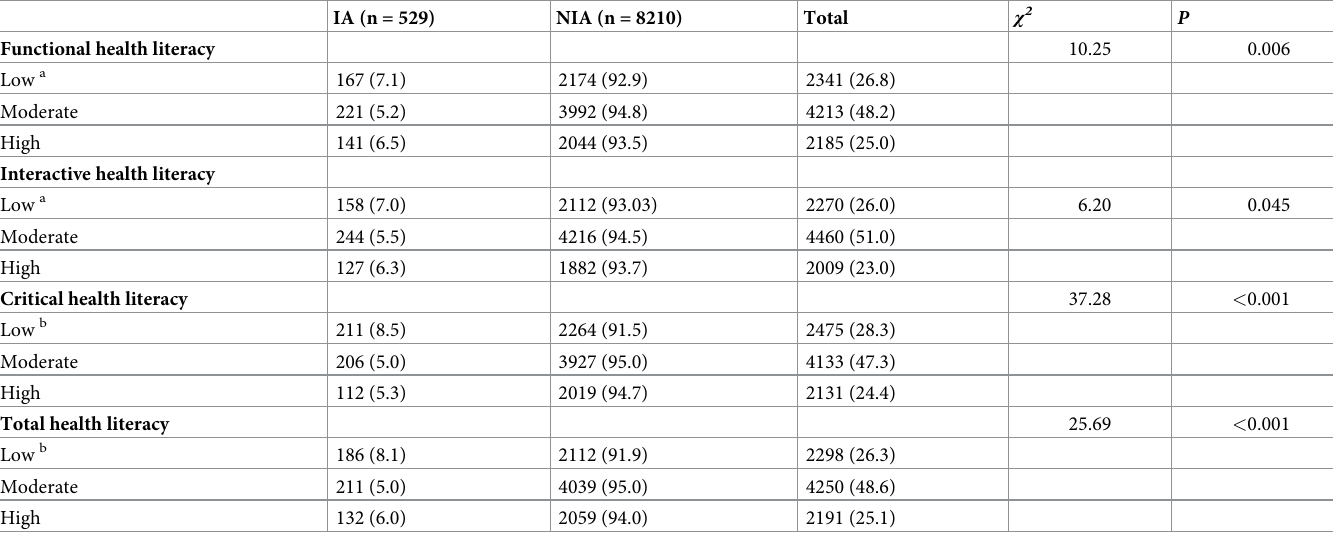
Table 2. Comparison of health literacy across different dimensions between IA and NIA